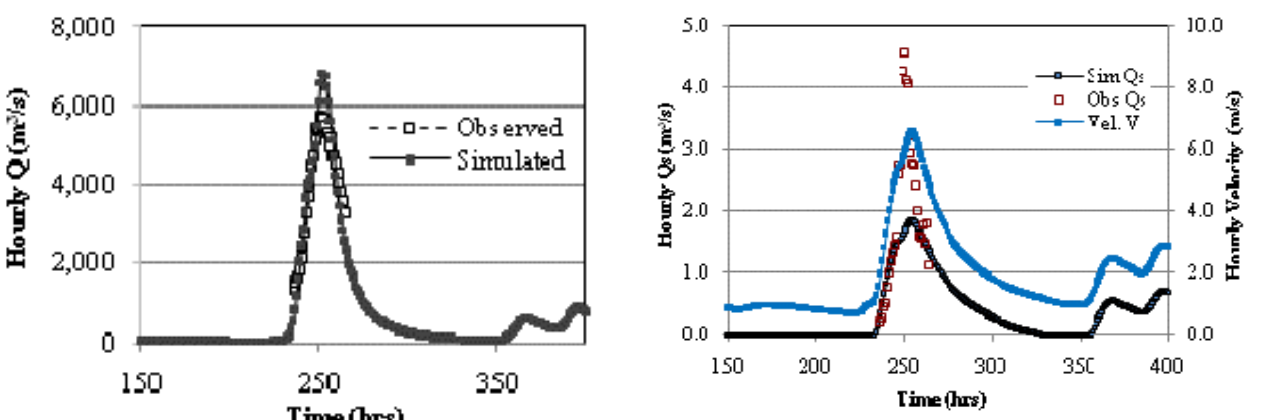
Fig. 9. Hourly water discharge at Tateyama station (11 July 2002).